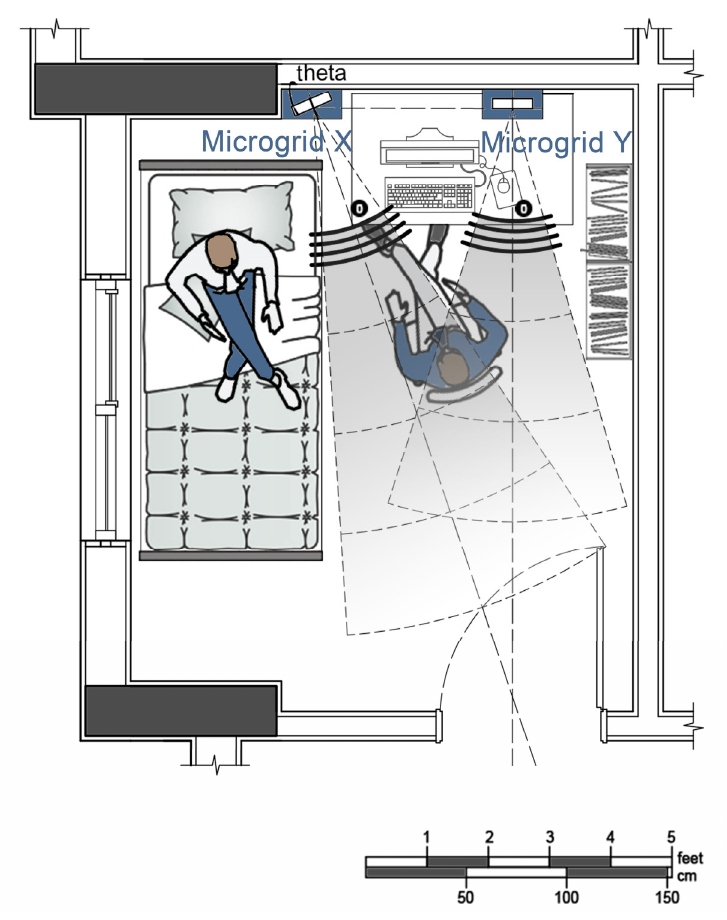
Figure 2. Microgrids installed in the experiment room with a spatial configuration.